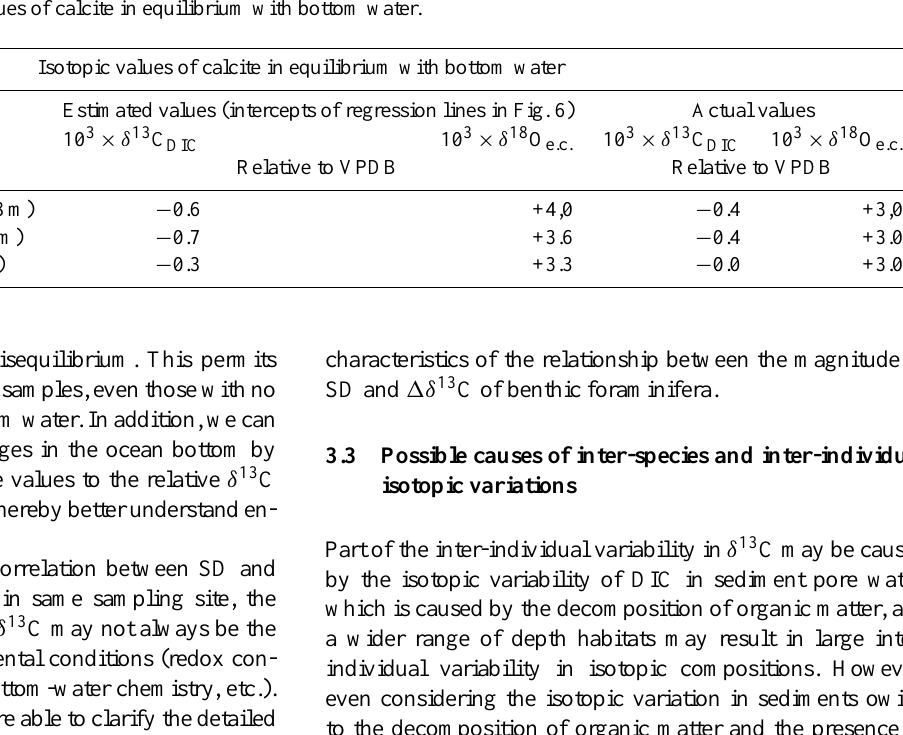
Table 3. Comparison of predicted isotopic values of calcite in equilibrium with bottom water at the study sites (intercepts of regression lines